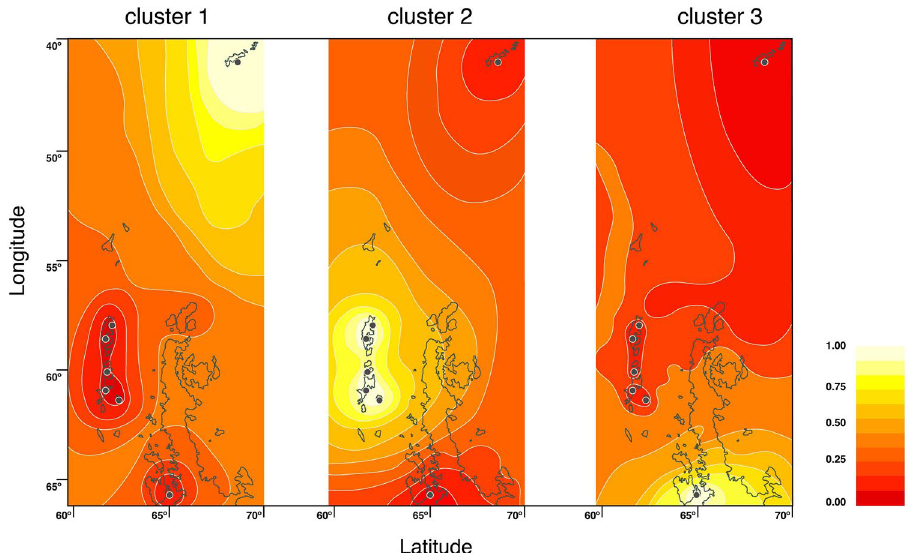
Figure 2. Spatial output of the Geneland analysis of K. subquadrata populations. Black circles indicate the relative positions of the sampled populations. Darker and lighter shading are proportional to posterior probabilities of membership in clusters, with lighter (yellow) areas showing the highest probabilities of clusters. Cluster 1: Signy Island; Cluster 2: Penguin, King George, Greenwich, Livingston and Deception Islands: Cluster 3: Doumer